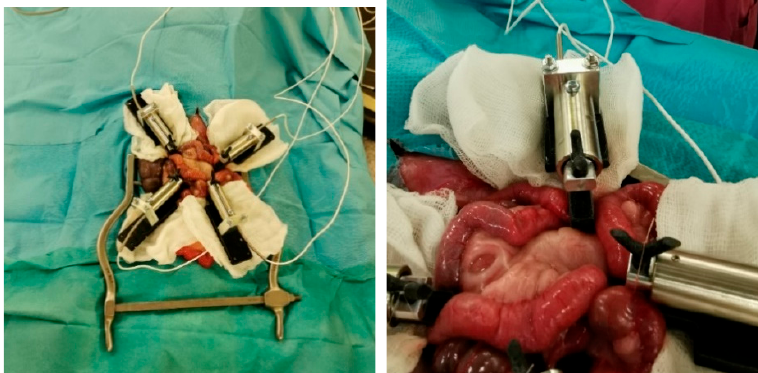
Figure 11. Experimental setup for parallel suture tension measurements.